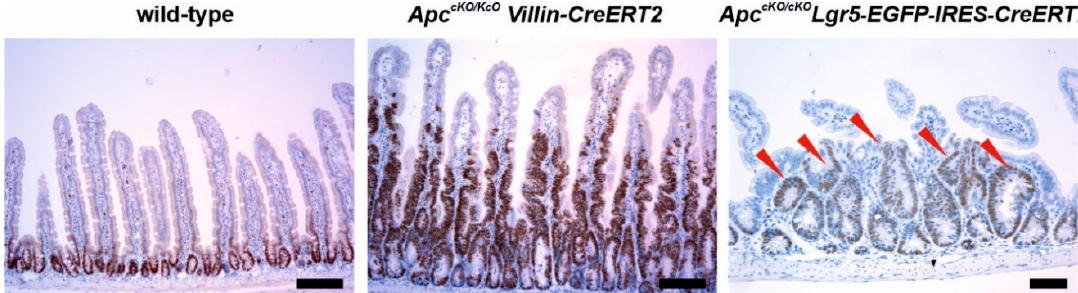
Figure 3. Crypt hyperplasia and microadenomas arising in the Apc-deficient small intestine. Immunohistochemical localization of proliferating cell nuclear antigen (PCNA; brown cell nuclei) in mice of the indicated genetic background. The middle microphotograph shows the hyperplastic crypt compartment developed in Apc cKO/cKO Villin-CreERT2 mice seven days after tamoxifen administration; the right image shows microadenomas (red arrowheads) formed in the Apc cKO/cKO Lgr5-EGFP-IRES-CreERT2 small intestine 21 days after tamoxifen administration. Sections were counterstained with hematoxylin (blue nuclear signal); scale bar: 0.3 mm (adopted from Reference [111] ).